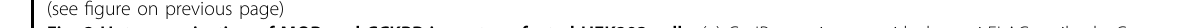
Fig. 2 Heteromerization of MOR and CCKBR in co-transfected HEK293 cells. ( a ) Co-IP experiments with the anti-FLAG antibody. Compared to the IgG group, HA-MOR could be co-immunoprecipitated with FLAG-CCKBR from the lysate of HEK293 cells, stably overexpressing HA-MOR and FLAG-CCKBR. Supernatants after Co-IP reaction indicated that not all MORs form heteromers with CCKBRs. b Co-IP experiments with the anti-HA antibody. FLAG-CCKBR was also co-immunoprecipitated with HA-MOR. c FLIM image of EGFP in different co-expressing cells. Compared with the group expressing MOR-EGFP alone or the MOR-EGFP- and mCherry-co-expressing group, the lifetime of MOR-EGFP in the MOR-EGFP- and CCKBR- mCherry-co-expressing group showed blueshifting, indicating the shortened EGFP fl uorescence lifetime. d Statistics of EGFP fl uorescence lifetime in ( c ). e FRET assay results. FRET ef fi ciency of the MOR-EGFP- and CCKBR-mCherry-co-expressing group was signi fi cantly higher than the EGFP- and mCherry-co-expressing group (negative control) or the MOR-EGFP- and mCherry-co-expressing group. The EGFP-mCherry-fusion-protein-expressing group was a positive control. *** p < 0.0001, t -test. Data are represented as the mean ±